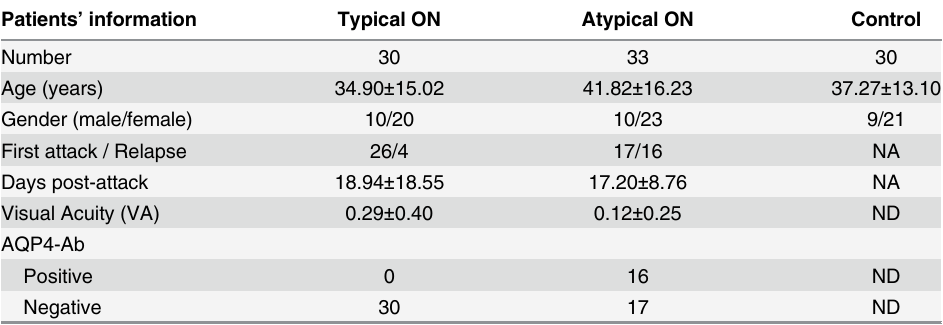
Table 1. Demographic and clinical features of patient cohorts and controls. Patients ’ information Typical ON Atypical ON Control Number